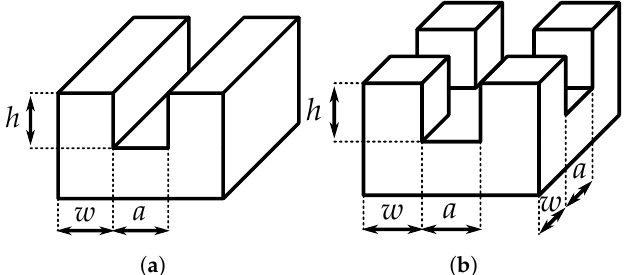
Figure 5. Characteristic dimensions of the surface structures. ( a ) Lamellar structures. ( b ) Pil- lared structures.